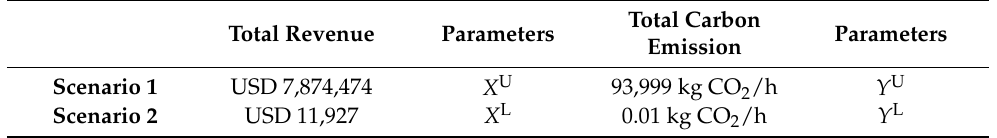
Table 14. Parameters required for fuzzy optimisation.